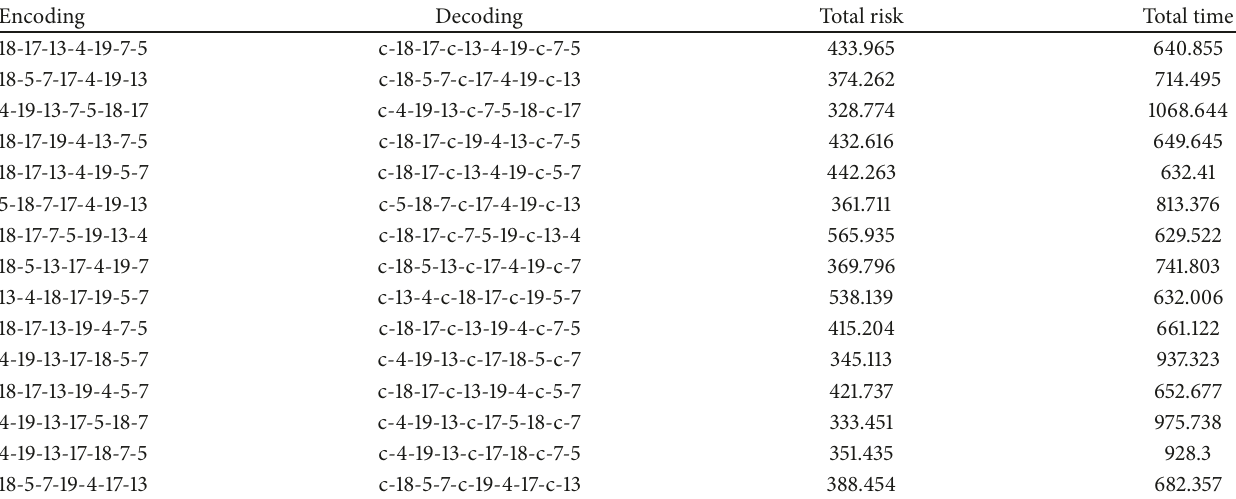
Table 12: Pareto solution set of robust control parameters Γ =10 for distribution center c. Encoding